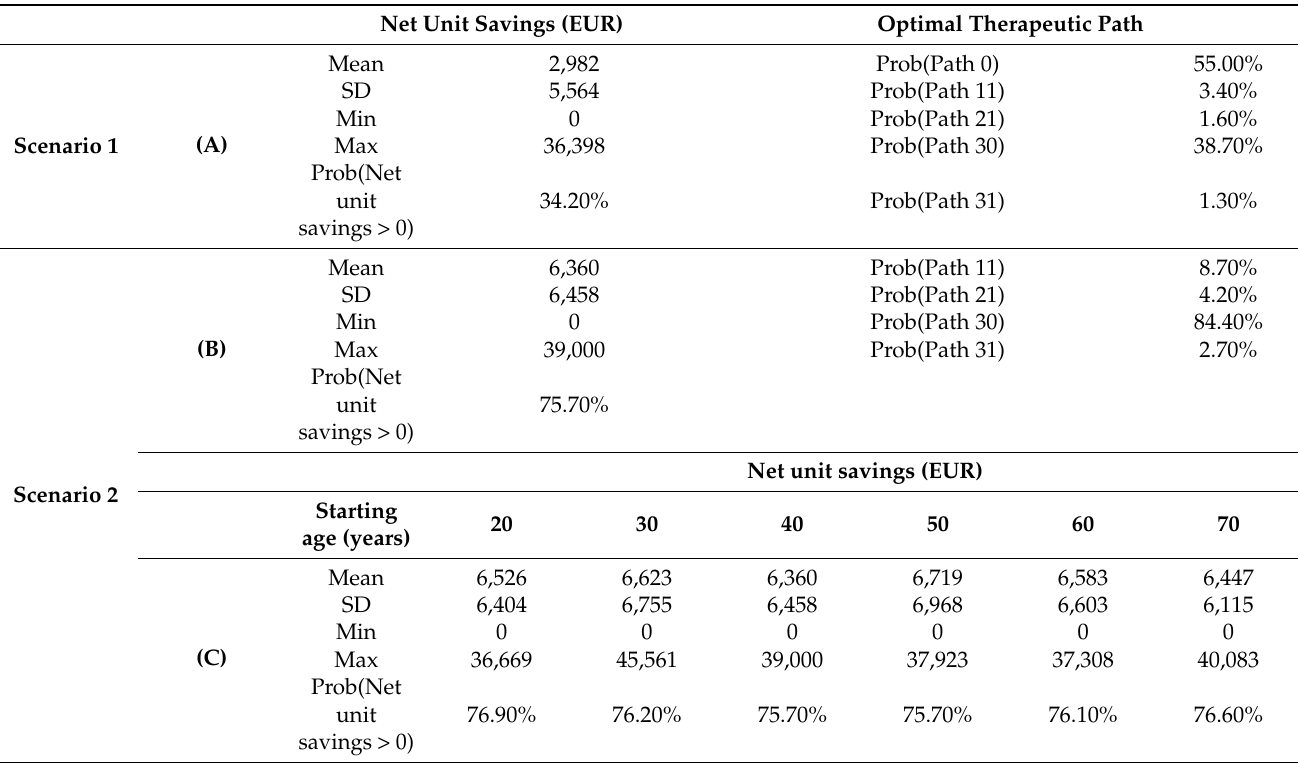
Table 4. Sensitivity and scenario analysis